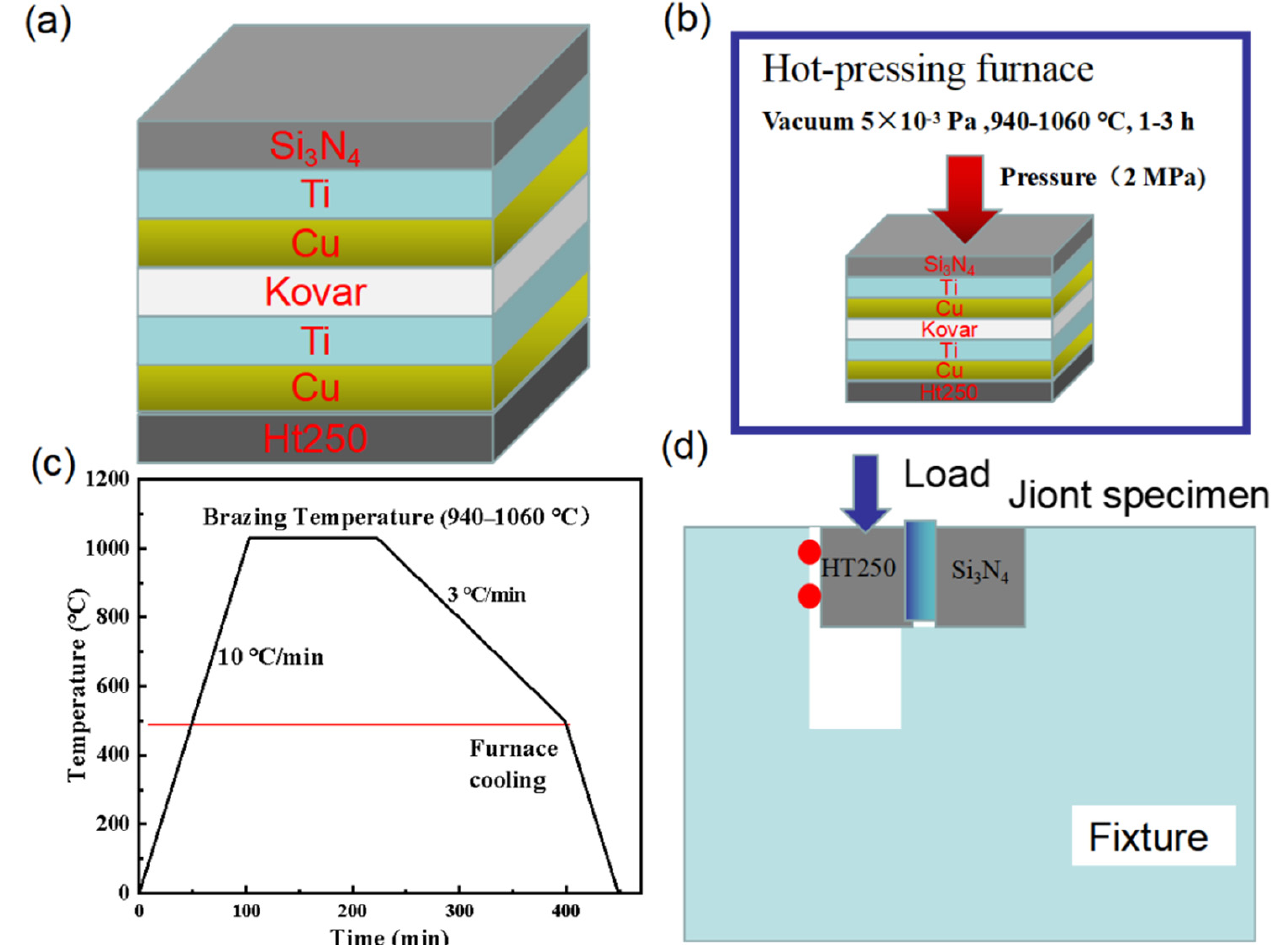
Figure 2. Schematic diagram of ( a ) workpiece assembly, ( b ) experimental process, ( c ) thermal cycle curve, and ( d ) shear test fixture.